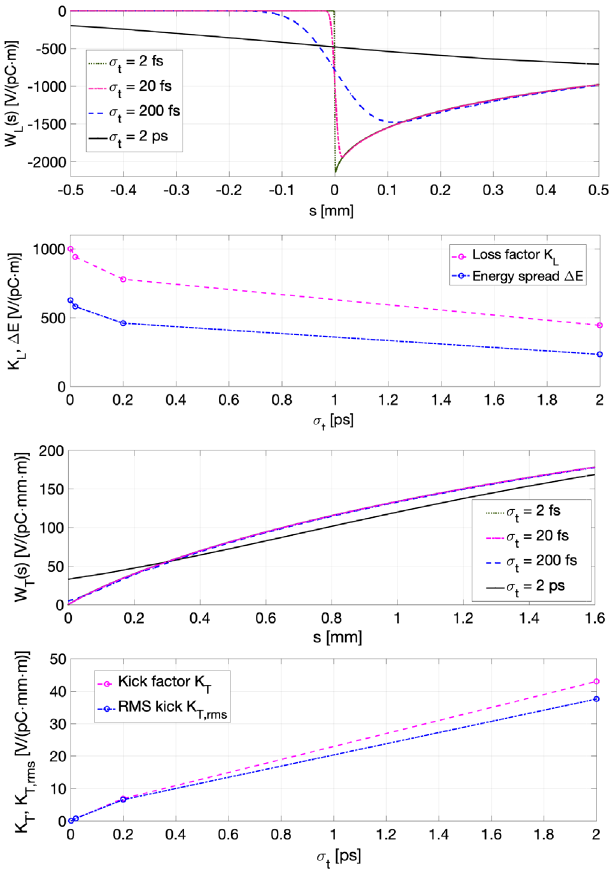
FIG. 12. First plot from the top: longitudinal wakefield poten- tial assuming 4 mm aperture in the rf-structure. The calculation is repeated for several Gaussian bunches with a length of 4 σ Second plot from the top: corresponding loss factor and local induced energy spread. Third plot from the top: transverse wakefield potentials (calculated in the same conditions as for the previous plots). Last plot on the bottom: corresponding local transverse kick factor and RMS kick.